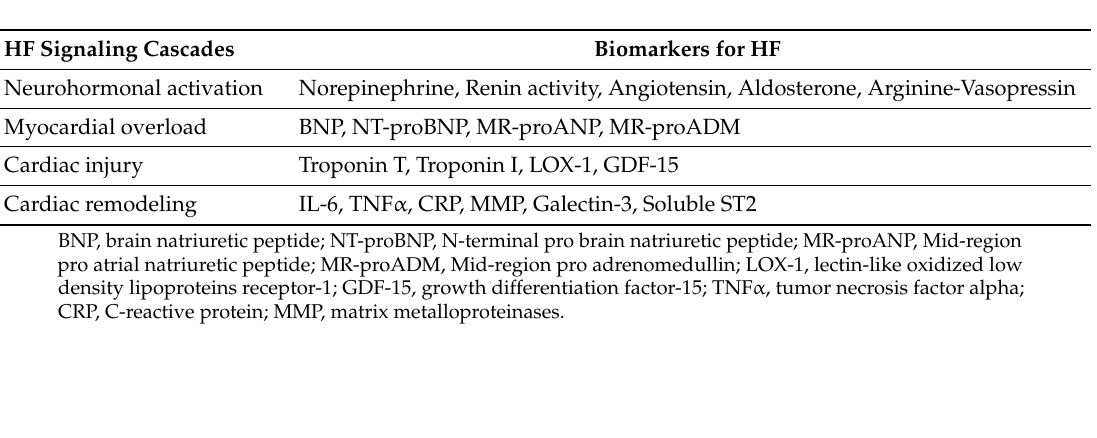
Table 3. HF signature signaling cascades and the key factors that have been proposed to be the HF